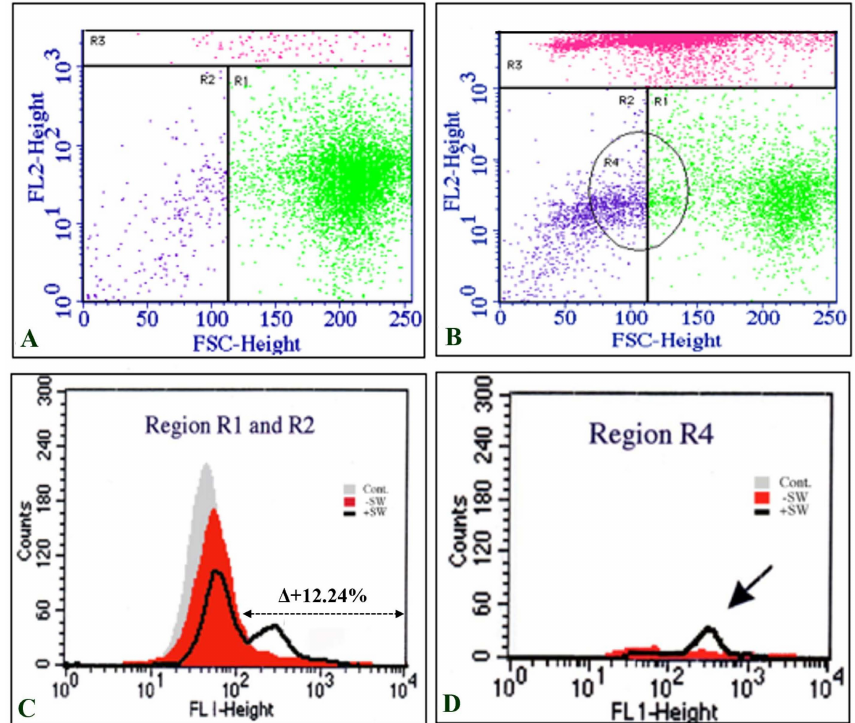
Figure 3. Double-staining flowcytometric analysis of TOS-1 cells. ( A ) Dot plot of the sham control cell population stained with propidium iodide (PI) (FL1-Hight). ( B ) Dot plot of the shock-wave-treated cells stained with PI. Gated R3 region represents high intensity of PI in dead cells. ( C ) Intensity of MSGG antigen stained with mAb-RM1 (FL1-Hight) on the live cells located in the area of R1 and R2 (low intensity of PI). ( D ) The majority of cells with enhanced expression of MSGG are located in R4, which represents the smaller cells (FSC-Height) in the cell population after the shock waves.